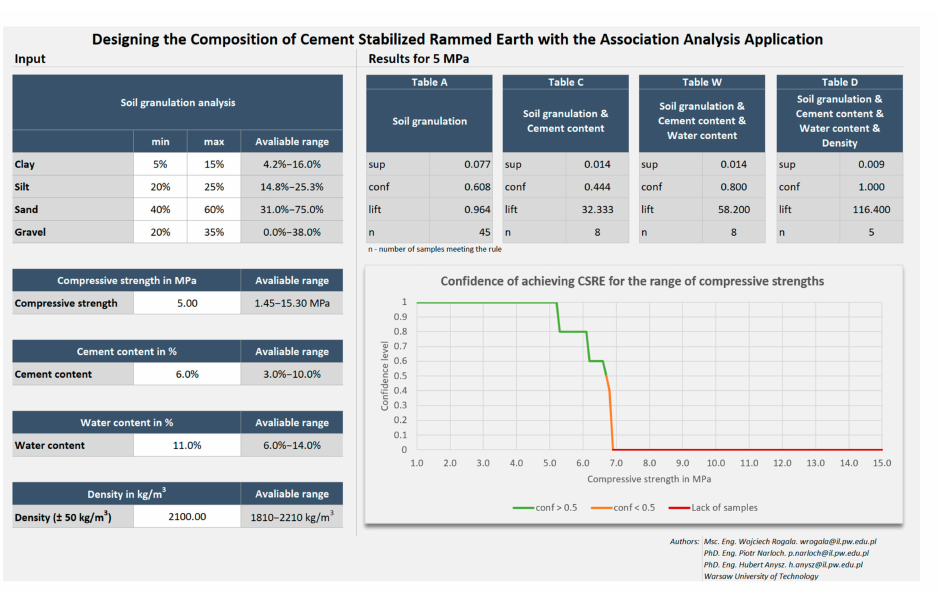
Figure 13. The appearance of the